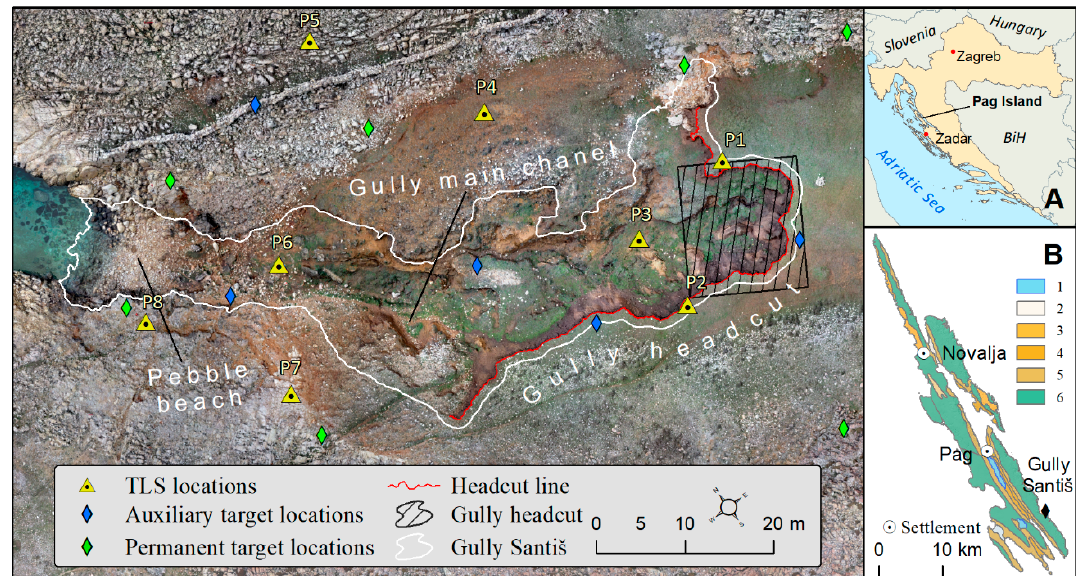
Figure 1. Study area covering complex morphology of gully Santiš (( A )—location of Pag Island within Croatia; ( B )—location of gully Santiš within geological map of Pag Island ( 1—Water; 2 — Holocen deposits; 3 — Limestone breccia; 4—Flysch; 5 — Foraminiferal limestones; 6 — Rudist limestones )).